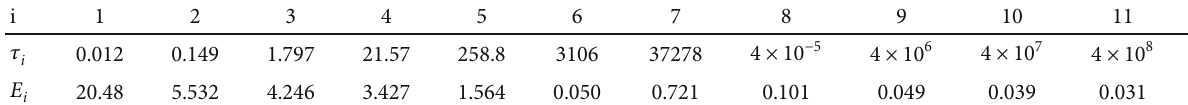
Table 2: The fi rst 11-order parameters of Prony series.